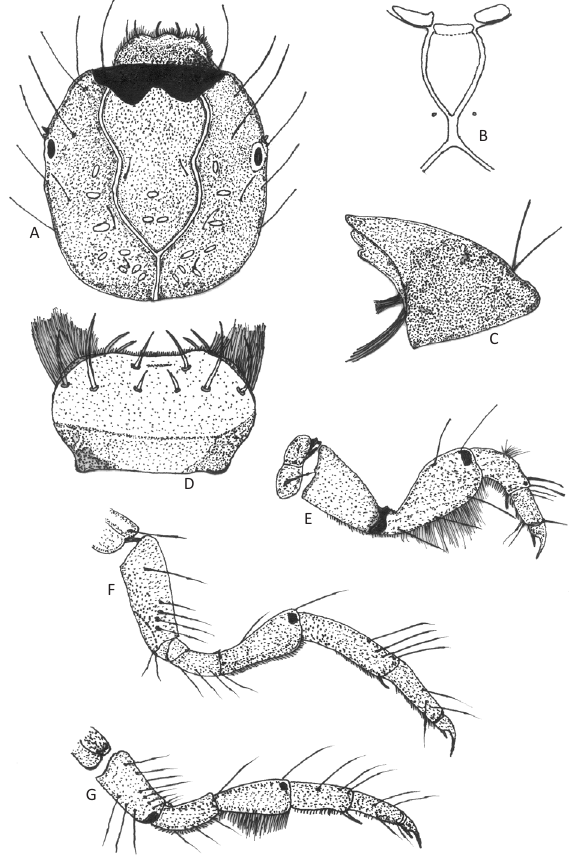
Figure 4. Larva of Lepidostoma nuburagangai sp. nov. A - Head, dorsal; B - ventral apotome, ventral; C - right mandible, dorsal; d - labrum, dorsal; E - right foreleg, posterior; F - right middle leg, posterior; G - right hind leg, posterior.